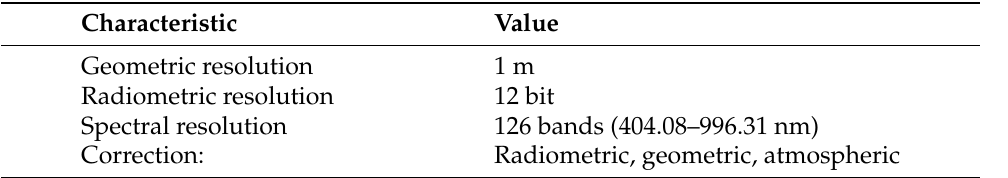
Table 1. Specifications of hyperspectral